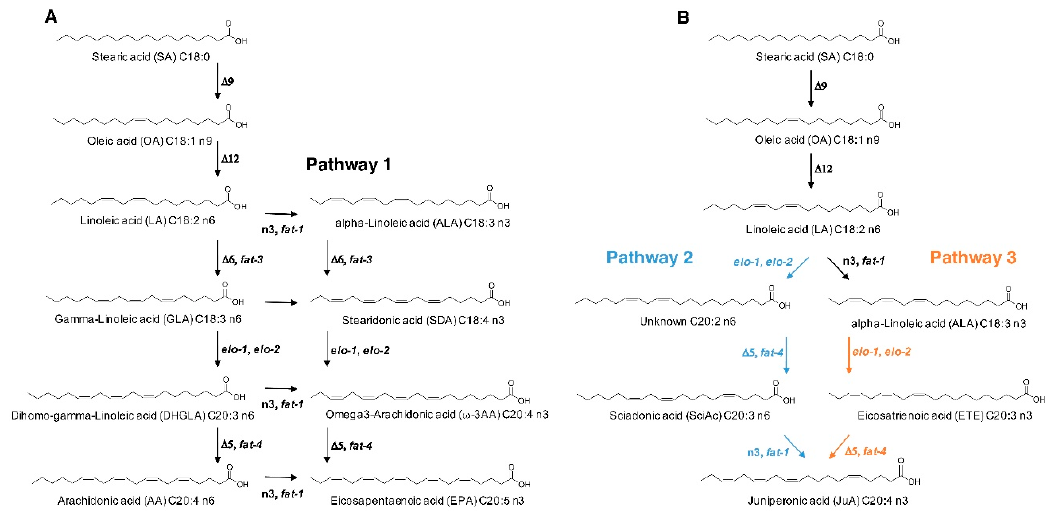
Formatted: Not Highlight